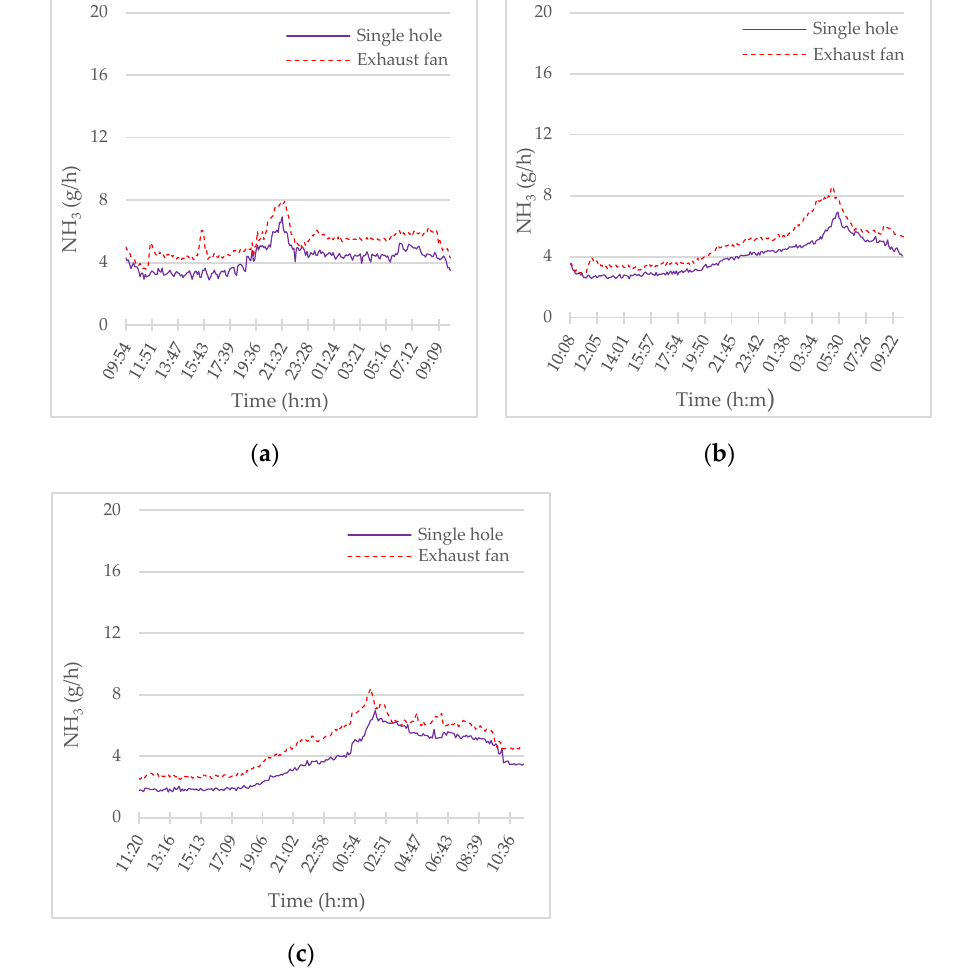
Figure 7. The ammonia (NH 3 ) emission reduction effect by spraying inside the curtain at the minimum operating rate of the barn exhaust fan (30%). ( a ) S/P (spray time, min./pause time, min.) 10/30, ( b ) S/P 10/10, ( c ) S/P 10/5. Table 1. Characteristics of sprayed